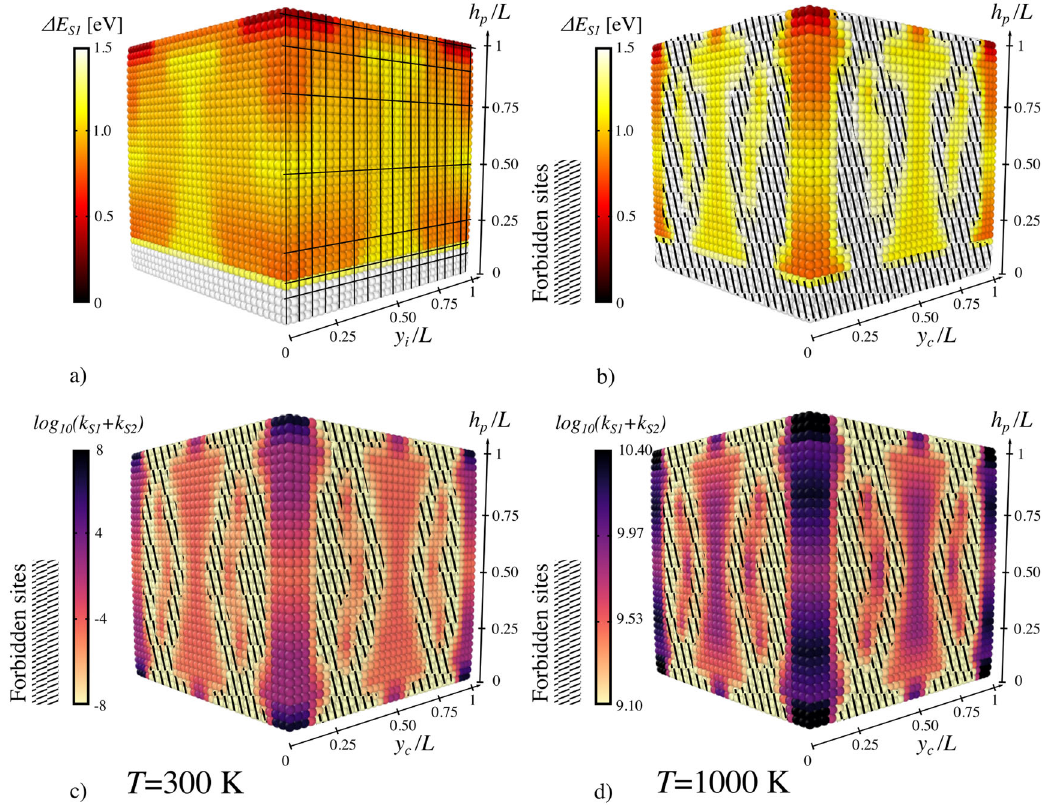
Fig. 4 Mapping of the surface dislocation nucleation energy and rate for an MgO nanocube at ε = 11%. a, b show the 0 K activation energy Δ E as function of the initial and relaxed nucleation centre positions, respectively y i / L and y c / L . Both plots consider only one slip system S 1 on each face. c, d show the cumulative dislocation nucleation rate log 10 ( k S 1 + k S 2 ) calculated using Eq. (1), respectively, at T = 300 and 1000 K. Both orthogonal slip systems S 1 and S 2 are considered on each face. The black grid shows the NEB calculation mesh. Forbidden sites are marked as hatched